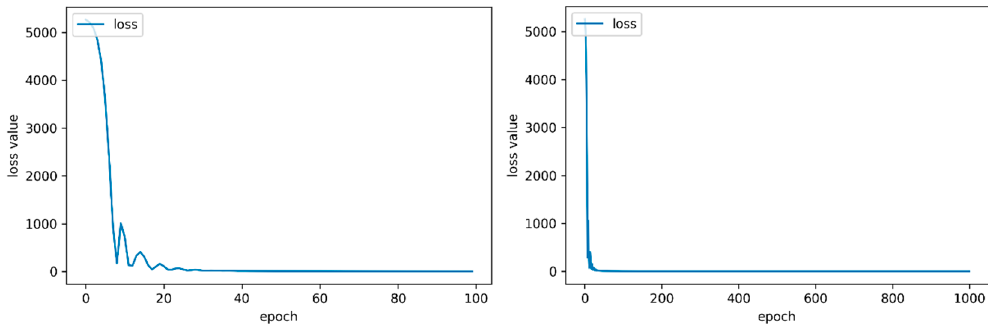
Figure 6. The training loss of the deep neural network (DNN) model with respect to epochs.